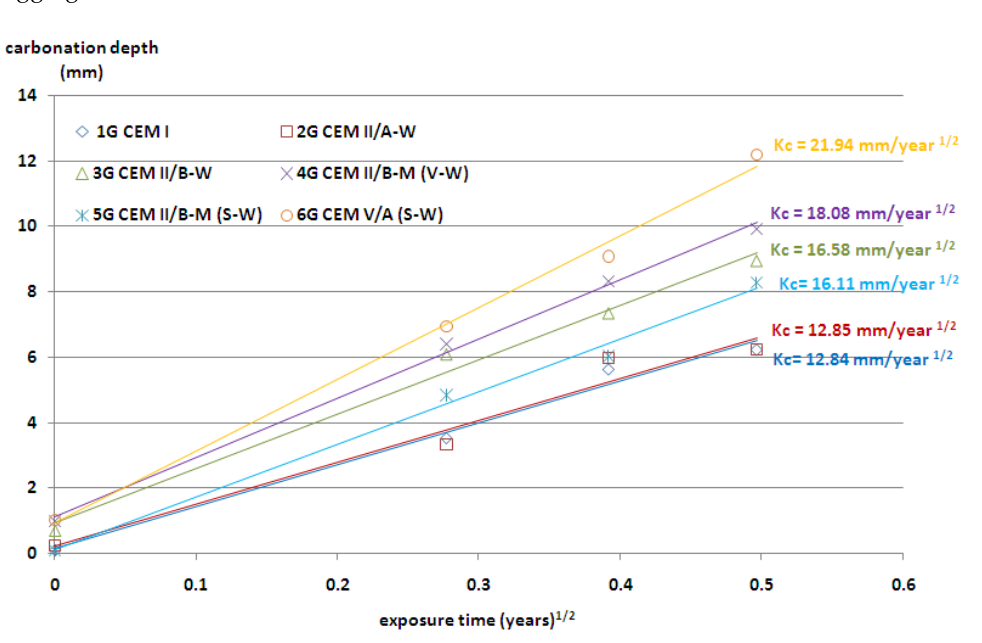
Figure 3. Depth of carbonation as a function of the square root of time (the values of K c coefficient); granodiorite aggregate.